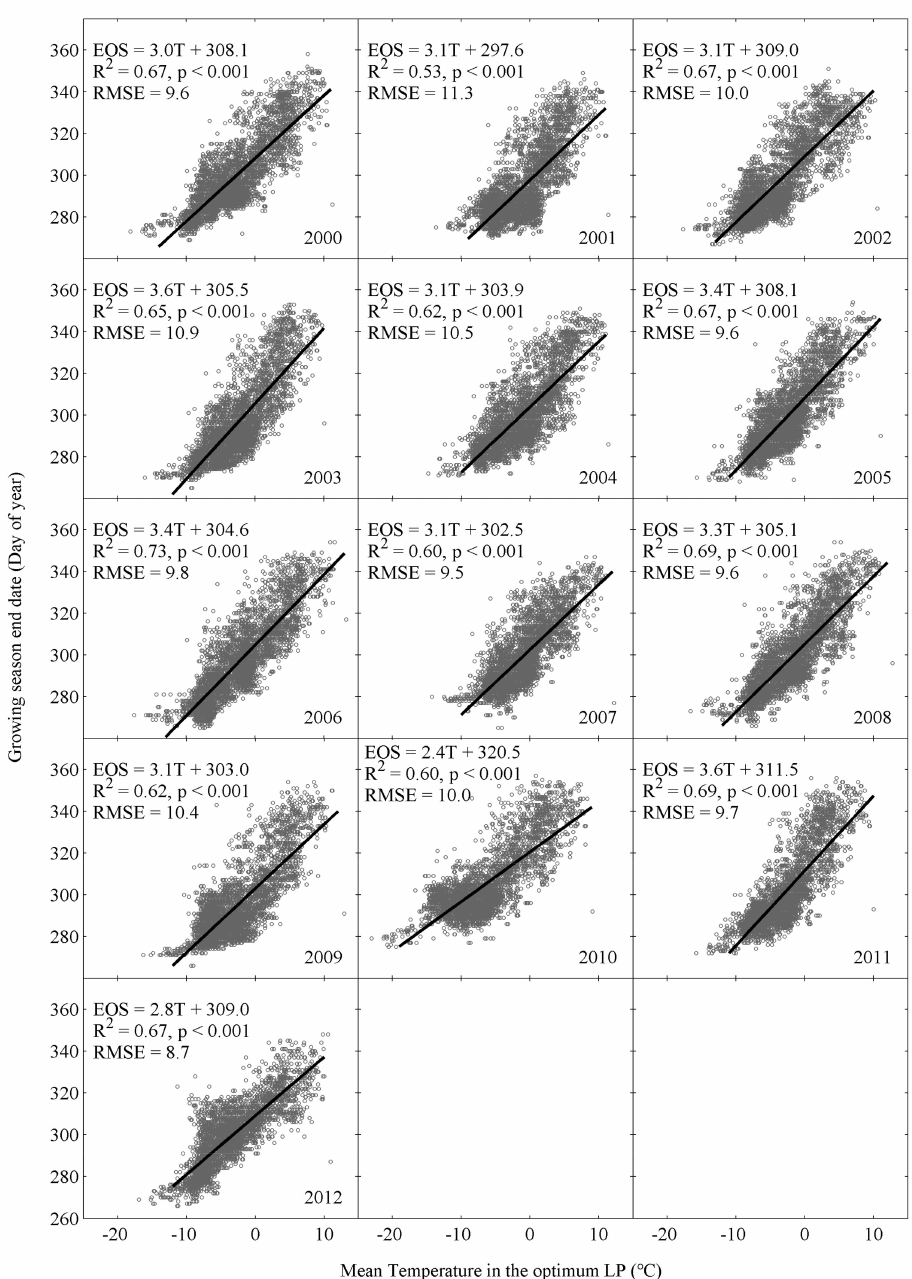
Figure 7. Spatial correlation and regression analyses between PSRI-derived growing season end date and mean temperature during the optimum length period (LP) in each year across the study area. Yearly partial correlation coe ffi cients between EOS and temperature during the optimum LP were all significant ( p < 0.001), and ranged from 0.62 (in 2001) to 0.80 (in 2006 and 2012), while partial correlation coe ffi cients between EOS and precipitation during the optimum LP were significant ( p < 0.001) in 9 of 13 years, and ranged from − 0.12 (in 2002) to 0.48 (in 2011). It should be noted that absolute values of partial correlation coe ffi cients between EOS and accumulated precipitation were much smaller than those of partial correlation coe ffi cients between EOS and the mean temperature (Table